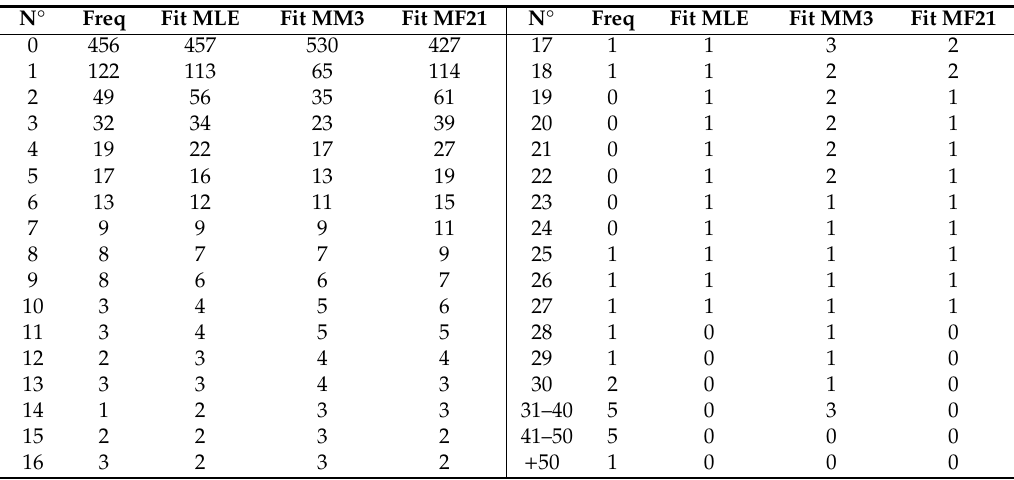
Table 1. Observed frequencies (Freq) for the number of organic livestock farms and estimated frequencies (Fit) by the maximum likelihood estimation (MLE), three moments method (MM3) and moments and frequencies method